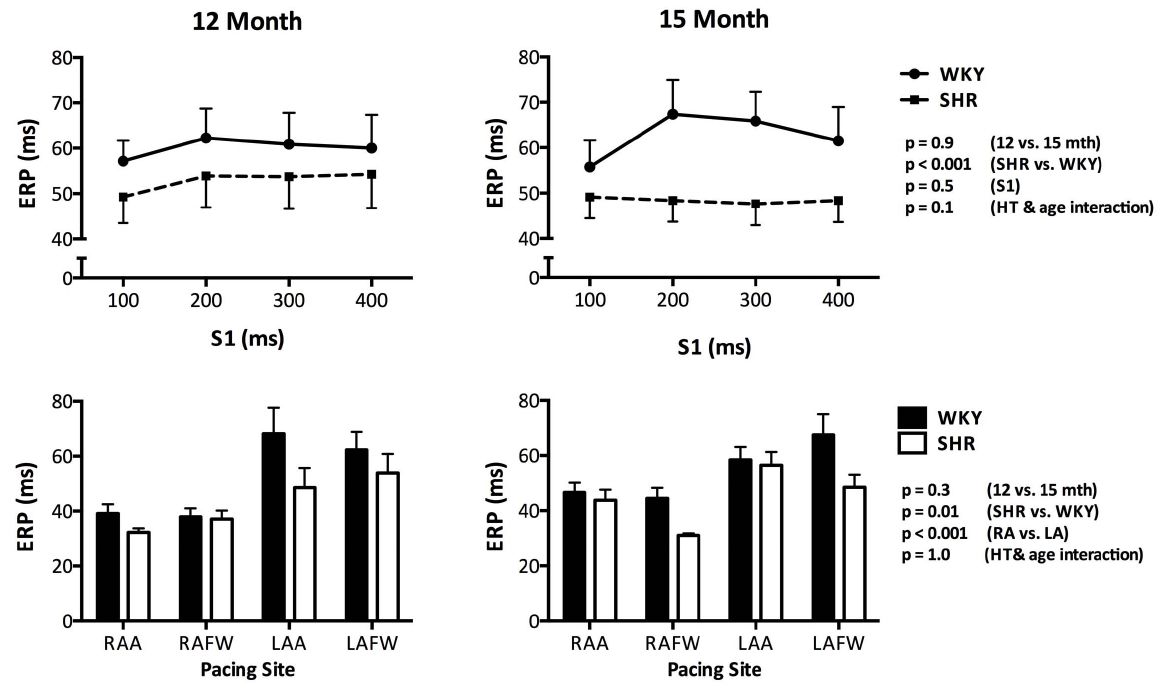
Figure 1. Atrial Refractoriness. Atrial ERP was significantly lower in the SHR as compared to the WKY controls at both time points (Mean ERP from LAFW shown in the top row). Although ERP was not affected by ageing or pacing cycle length (S1), higher ERP was seen in the LA as compared to the RA (Mean ERP with S1 @200 ms shown in the bottom row). Error bars denote standard error of the mean.